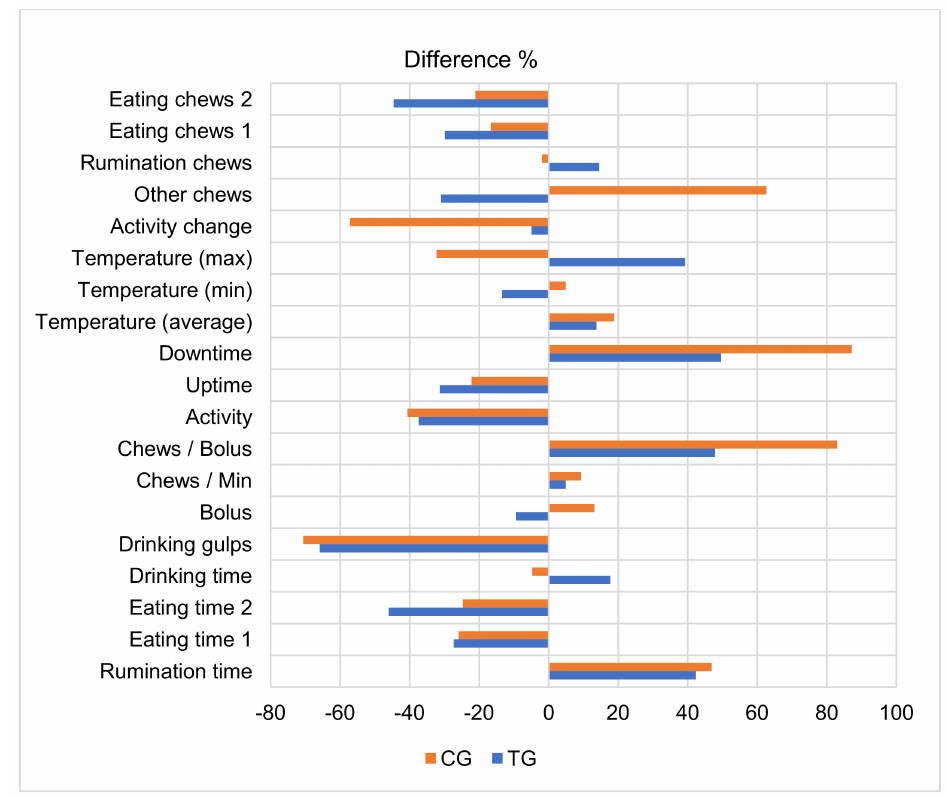
Figure 1. Comparison of the rumination behavior parameters during the last 30 days before calving and on the calving day. The differences between the mean values of the periods (period: the last 30 days before calving = 100%) are statistically significant. TG—subclinical ketosis group; CG—control